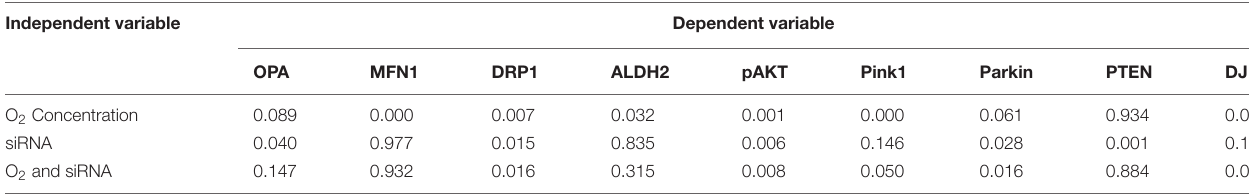
TABLE 1 | Summary of P -values of two-way MANOVA for protein expression levels. Independent variable Dependent variable OPA